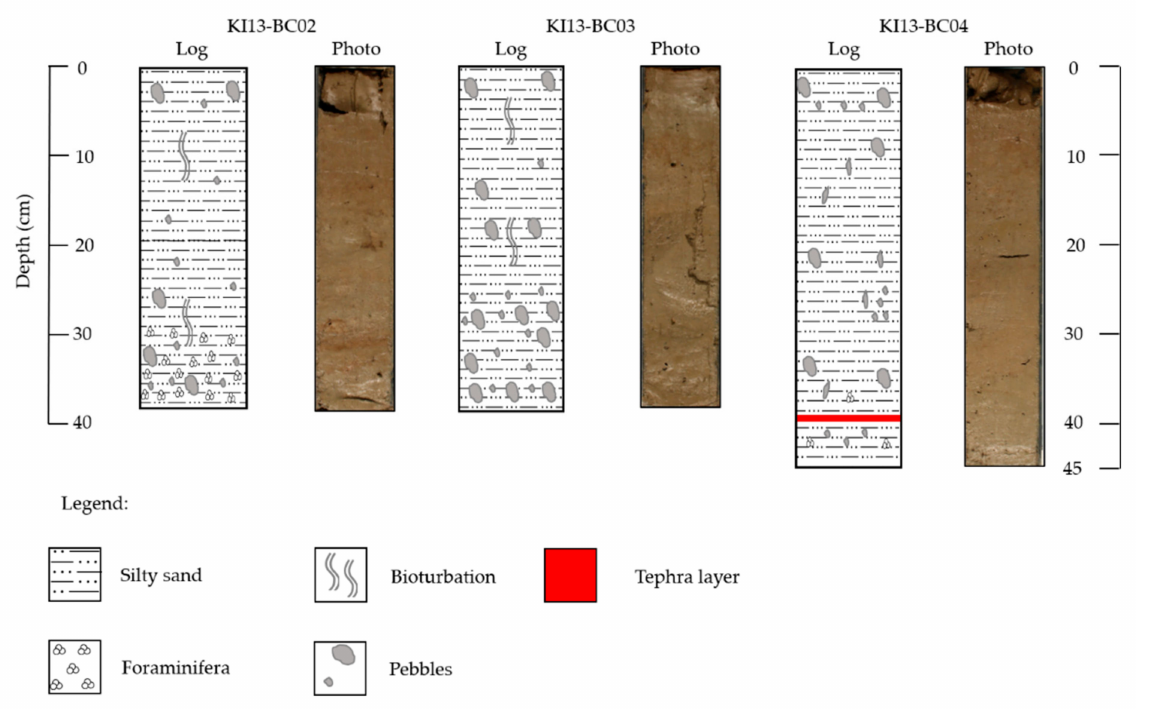
Figure 2. Sedimentological log and photo of three box cores.